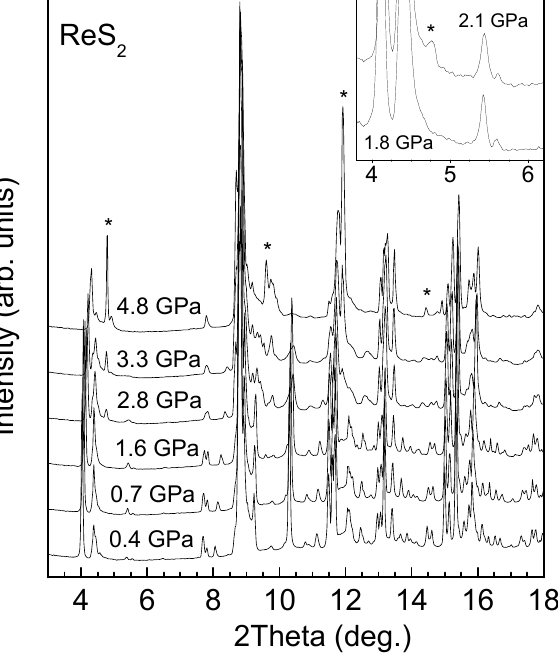
Figure 4. High-pressure synchrotron XRD measurements of synthetic 1T-ReS 2 up to ~5 GPa. The inset shows the appearance at low angles of a new reflection around 2 GPa. The asterisks indicate reflections that are not present in the zero-pressure scans and which can be attributed to the 1T’ phase.